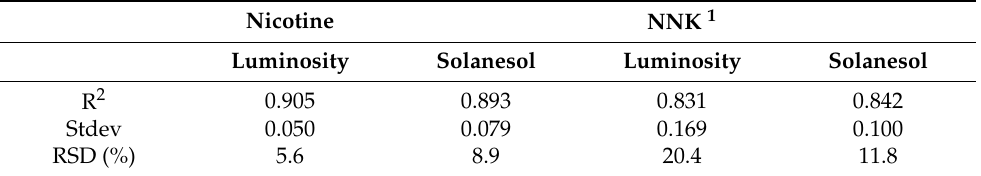
Table 1. Comparison of luminosity and solanesol average correlation curve fits for nicotine and NNK for 20 brands of commercial cigarettes.